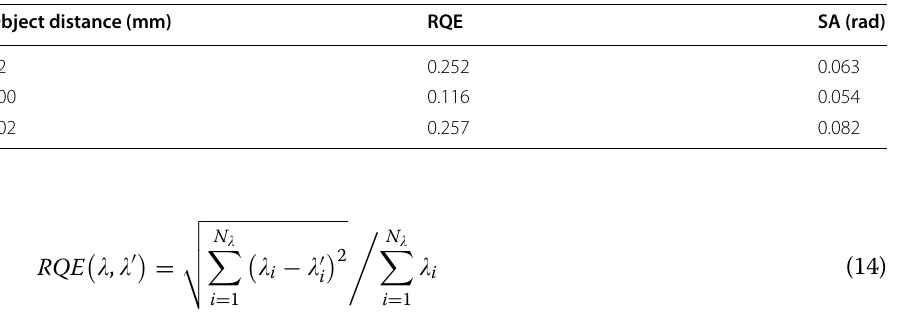
Table 2 The evaluation of spectral